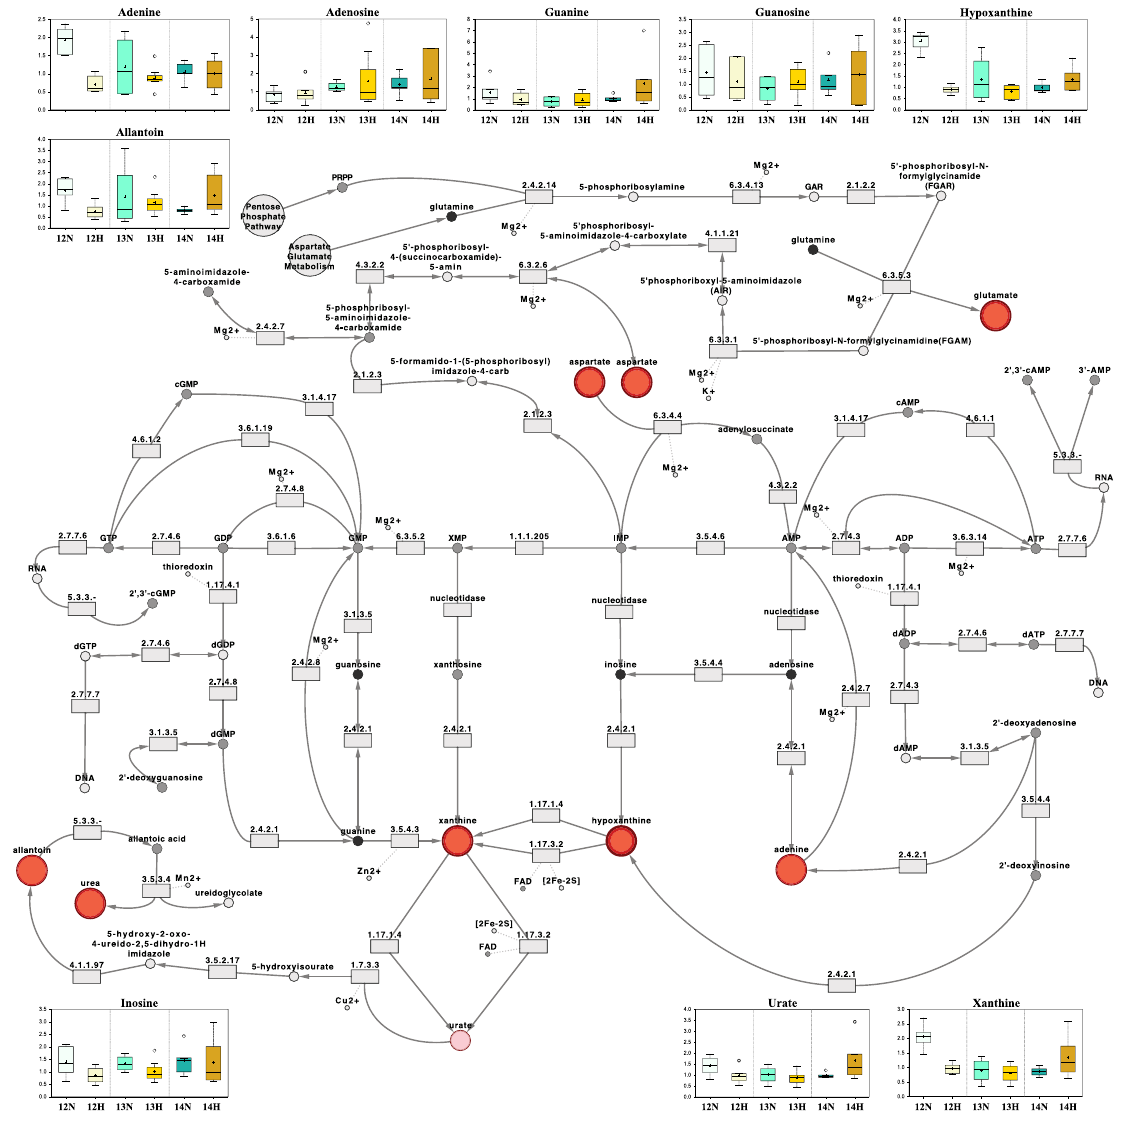
Figure 5. The purine metabolic pathway surrounded by the scaled intensities of relevant biochemicals. Biochemical node colour corresponds to day by progesterone (P4) interaction – dark red indicates a significant (p ≤ 0.05) interaction (node border thickness is inversely proportional to the magnitude of the p-value). Within these statistically significant nodes, node diameter is correlated to metabolic hierarchy (cofactor and intermediate metabolite nodes are smallest, followed by by-products, and central metabolites). Light red depicts an increasing trend (0.05 < p < 0.10), black depicts an identified amino acid which did not exhibit a day by progesterone interaction, and grey represents a biochemical present in the metabolic library but not detected in this study. Box plots: The y-axes are the relative metabolite concentrations, with the central horizontal line representing the median value with outer boundaries depicting the upper and lower quartile limits. Error bars depict the minimum and maximum distributions, with + representing the mean value and ○ the extreme data point. Abbreviations: Day 12 Normal P4 (12N), Day 12 High P4 (12H), Day 13 Normal P4 (13N), Day 13 High P4 (13H), Day 14 Normal P4 (14N), Day 14 High P4